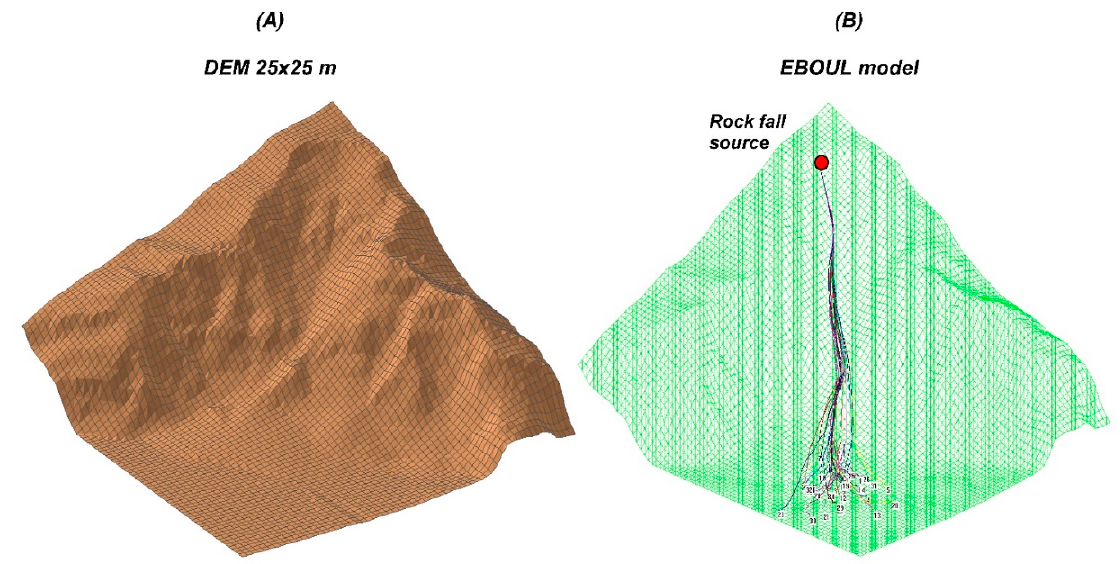
Figure 12. ( A ) Topographic model obtained from a 25 m × 25 m digital elevation model (DEM). ( B ) Rock fall trajectory modelling performed with EBOUL, based on the DEM.